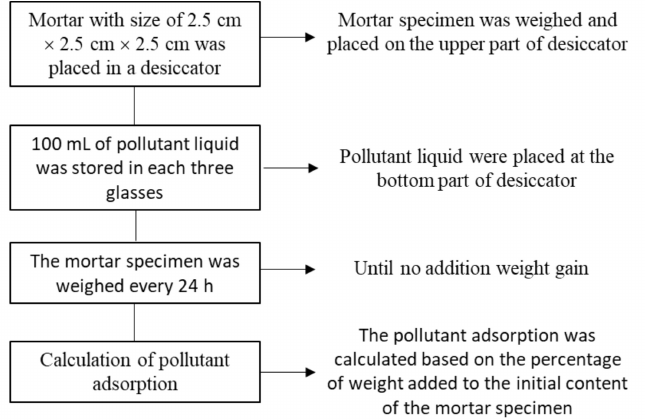
Figure 5. The process of pollutant adsorption